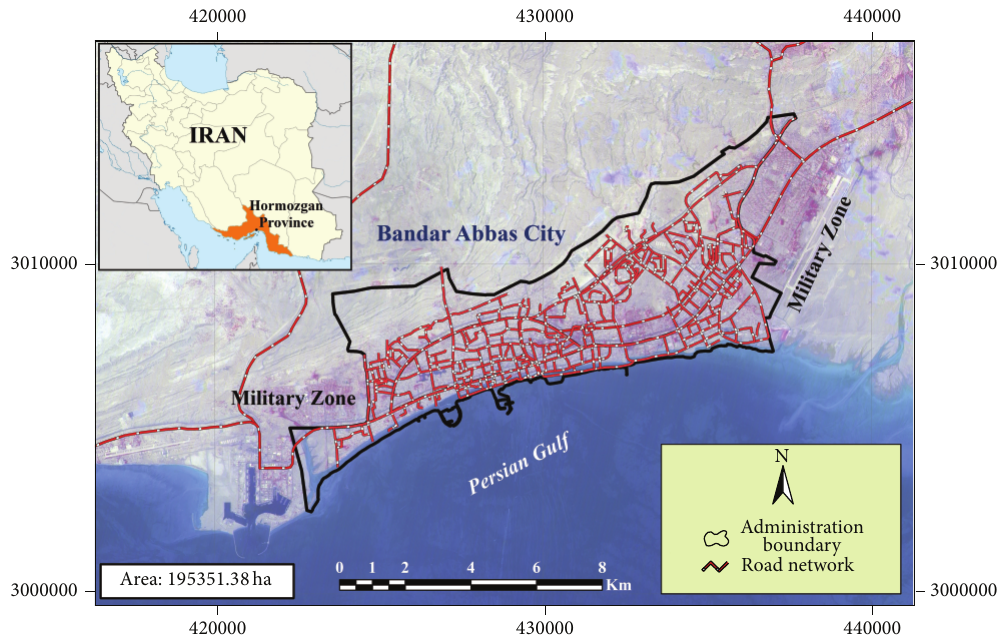
Figure 1: Bandar Abbas location in